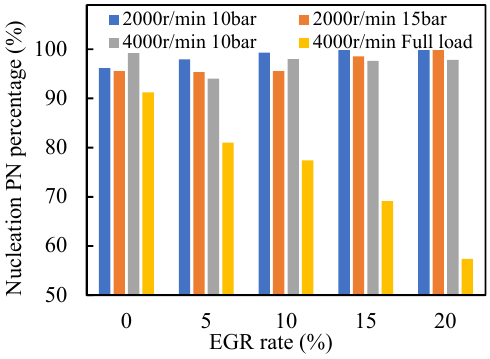
Figure 8. The percentage of nuclear particles.